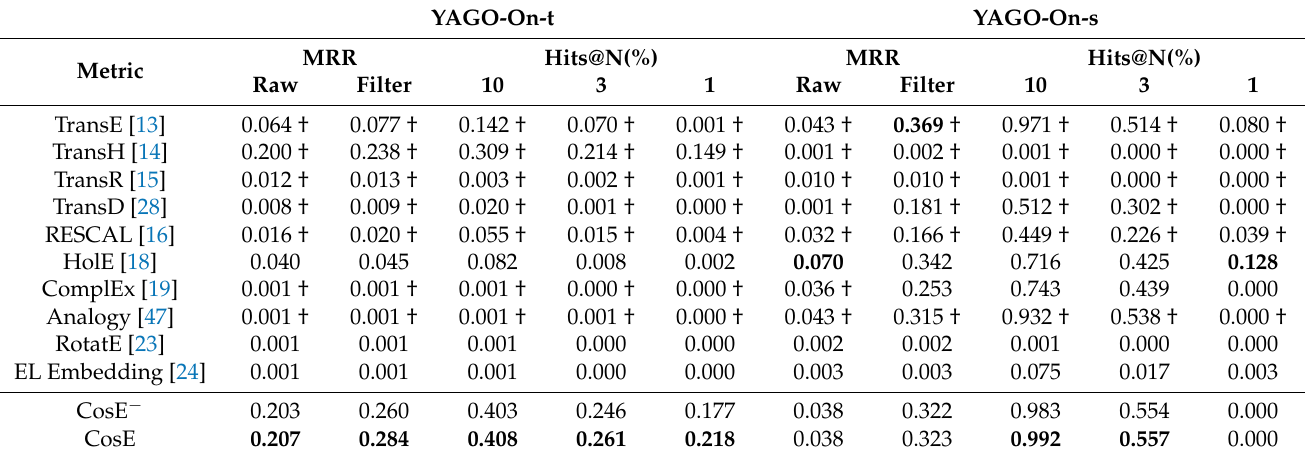
Table 8. The evaluated results on link prediction of transitivity and symmetry. YAGO-On-t